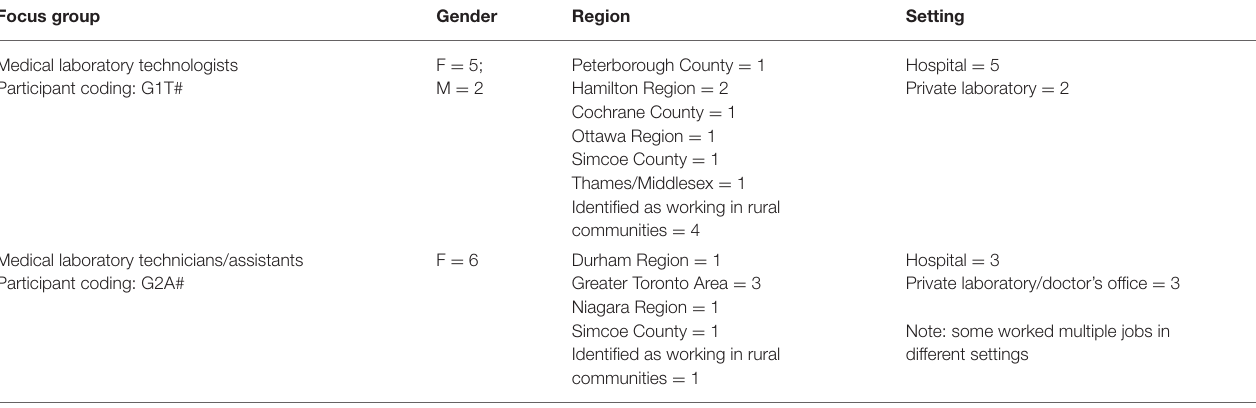
TABLE 1 | Characteristics of participants involved in focus groups.